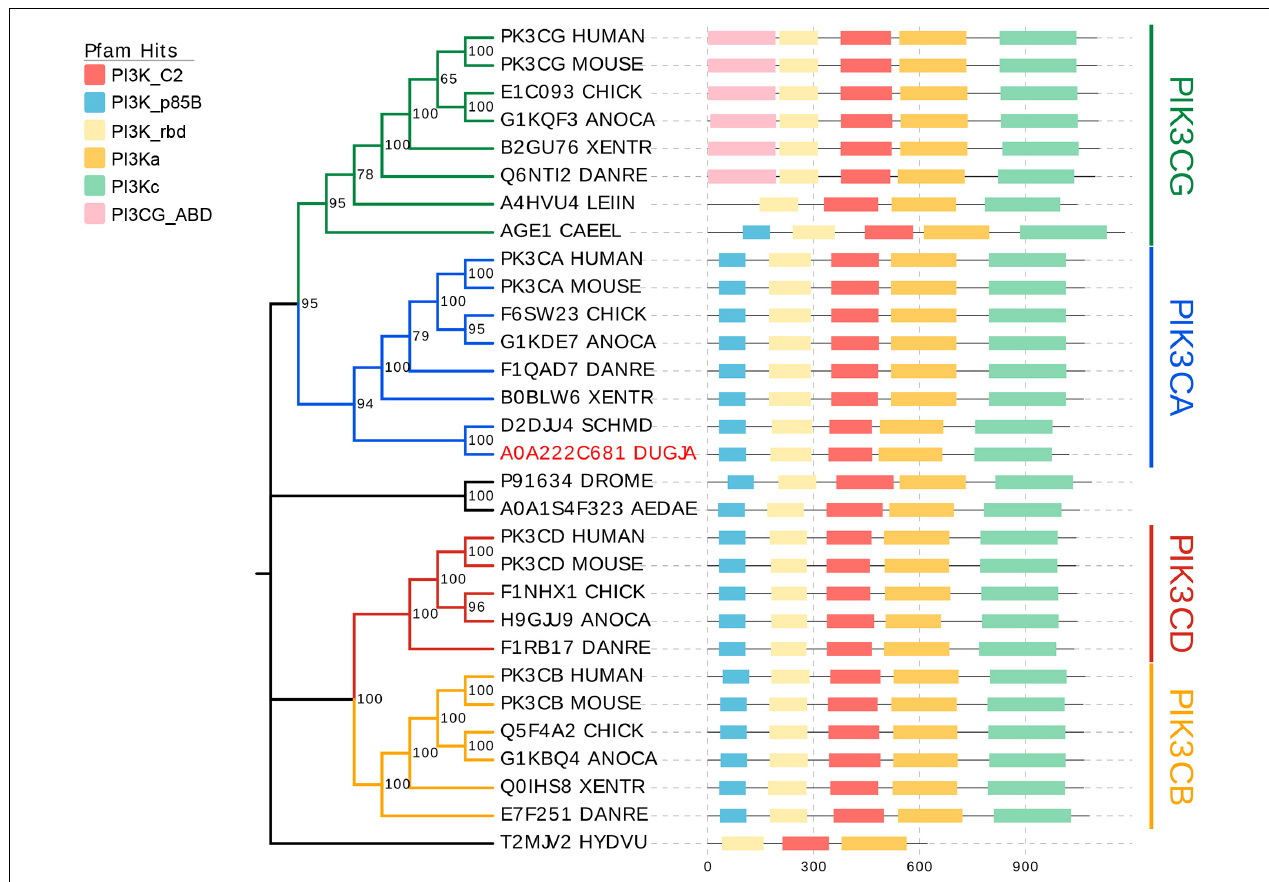
FIGURE 1 | Phylogenetic analysis of catalytic PI3Ks subunits. All selected genes encoding the catalytic subunits of Class I PI3K are mainly categorized into four clusters corresponding to PIK3CA (blue), PIK3CB (yellow), PIK3CD (red), and PIK3CG (green). Domain annotations for each sequence were determined using the Pfam database (Mistry et al., 2021). C2, C2 domain; p85B, p85-binding domain; rbd, Ras-binding domain; PI3Ka, PI3K accessory domain; PI3Kc, PI3K catalytic domain; PIK3CG_ABD, PIK3 catalytic subunit gamma adaptor-binding